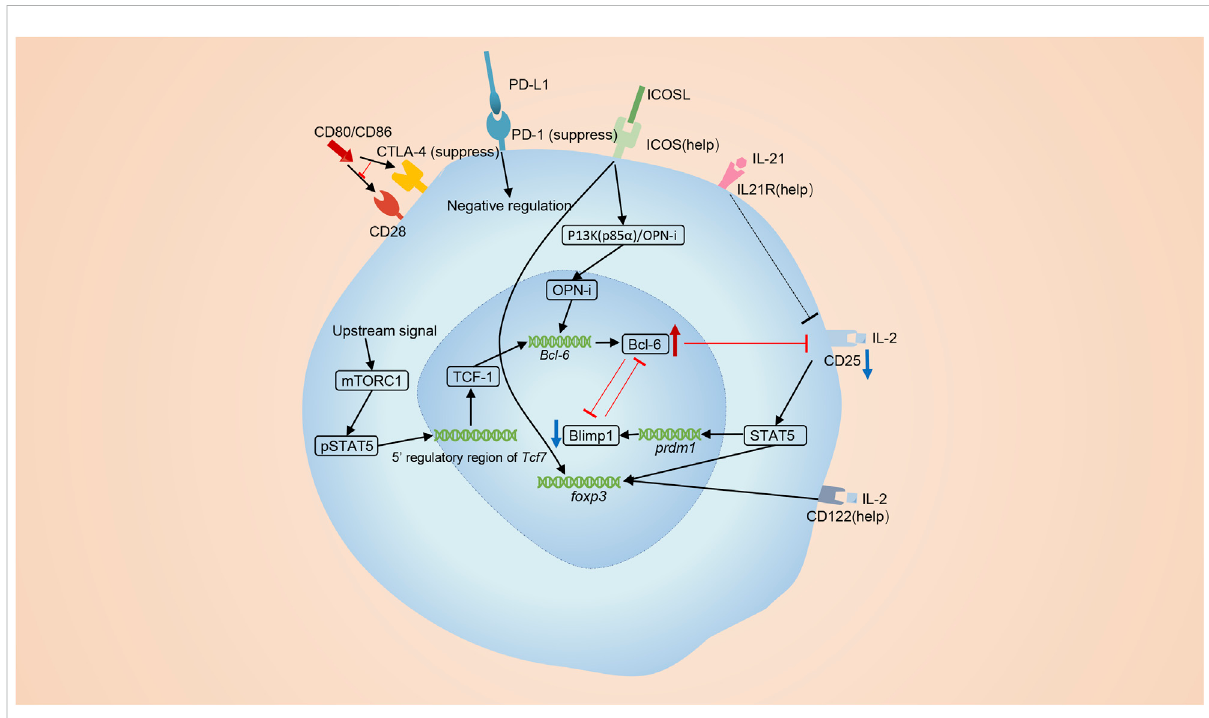
FIGURE 2 ThedifferentiationofTfrcells.TfrcellsareprimarilyderivedfromTregs.ICOSsignalingpromotesthedifferentiationofTfrcells.Thep85 α -OPN- i axis requires ICOS for the Bcl-6-dependent differentiation of Tfr cells. The interactions of CD28 on Tregs and CD80 on B cells is also required for optimal differentiation of Tfr cells. MTORC1 signaling elevates TCF1 to induce the differentiation of Tfr cells. lL-21 also has a positive effect on the number of Tfr cells. On the contrary, co-inhibitory molecules, CTLA4 and PD-1, negatively regulate the differentiation of Tfr cells. Bcl-6 and Blimp-1 are a pair of opposites. IL-2 signaling activates STAT5 and induces the expression of Blimp-1 while Bcl-6 restricts the expression of the receptor of IL-2,